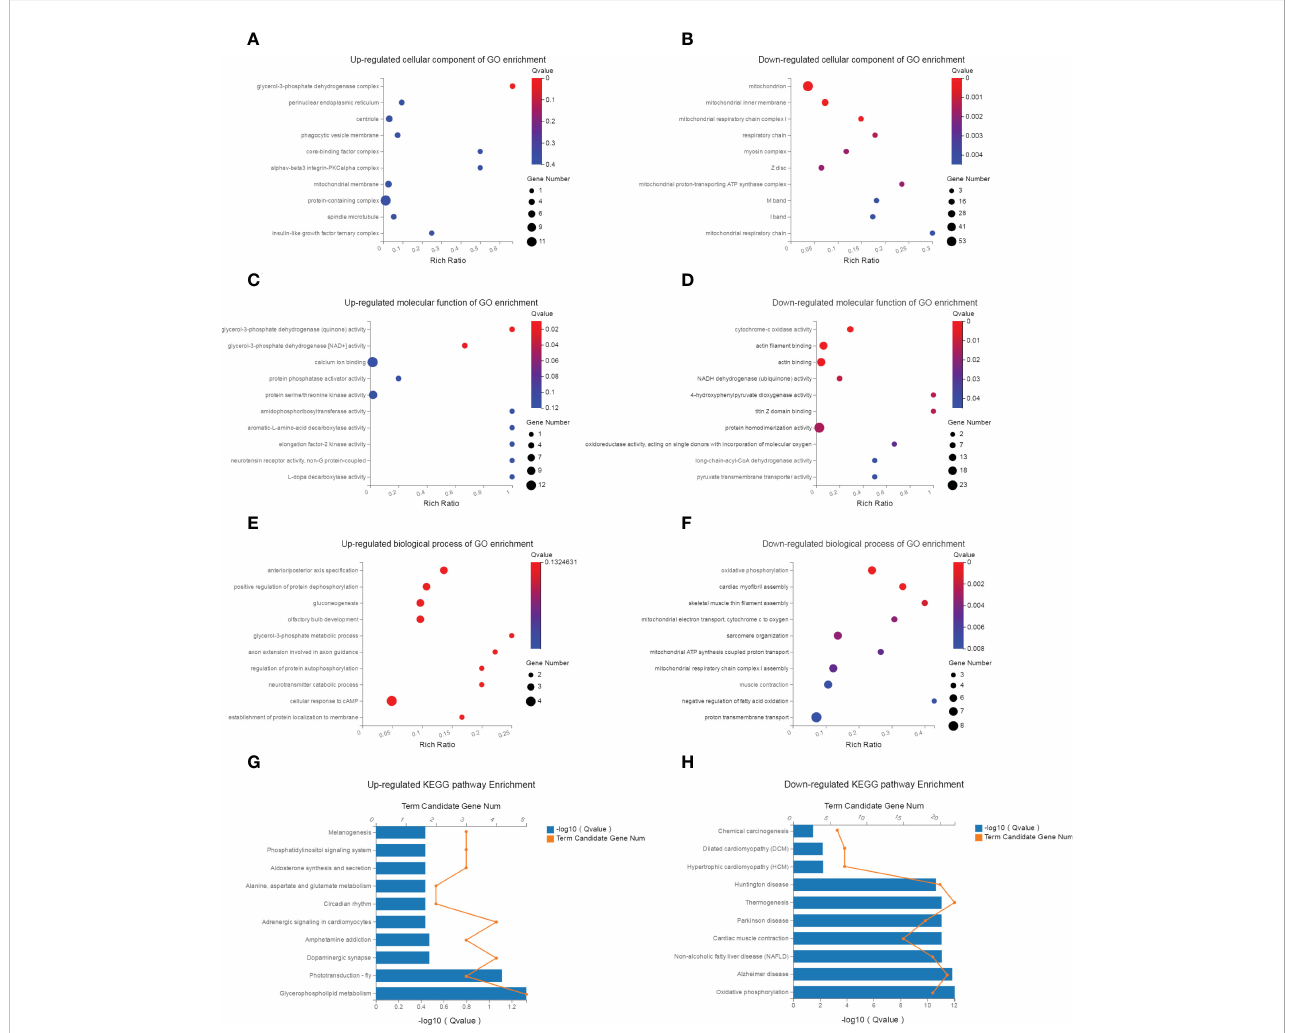
FIGURE 4 GO and KEGG pathway enrichment analysis. (A, B) The top 10 up- and down-regulated KEGG pathway terms of dif-mRNAs. The selection criteria of signi fi cant pathways or GO terms was FDR<0.05. (C, D) The top 10 up- and down-regulated biological process of GO terms for dif-mRNAs. (E, F) The top 10 up- and down-regulated molecular function of GO terms for dif-mRNAs. (G, H) The top 10 up- and down-regulated cellular component of GO terms for